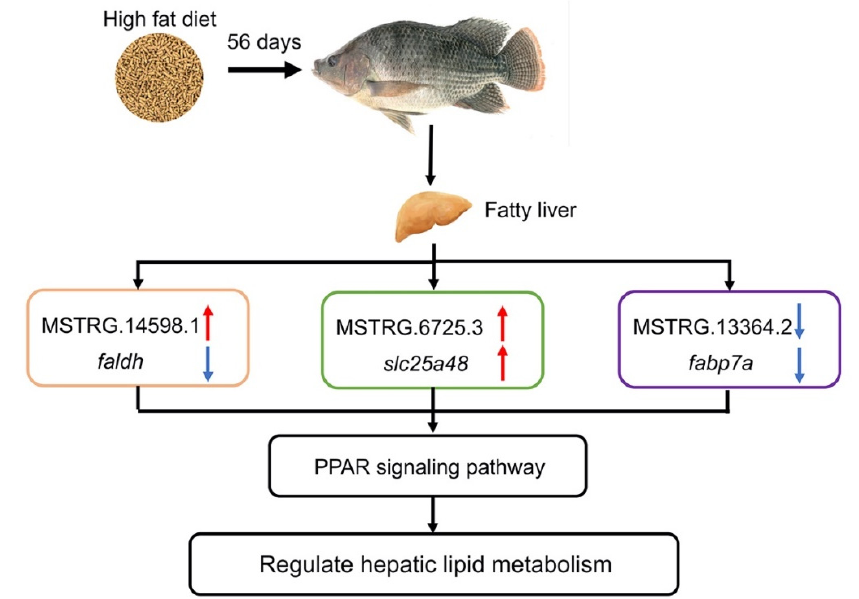
Figure 8. Diagram of lncRNA-mediated regulated pathway in the liver of GIFT fed a HFD for 56